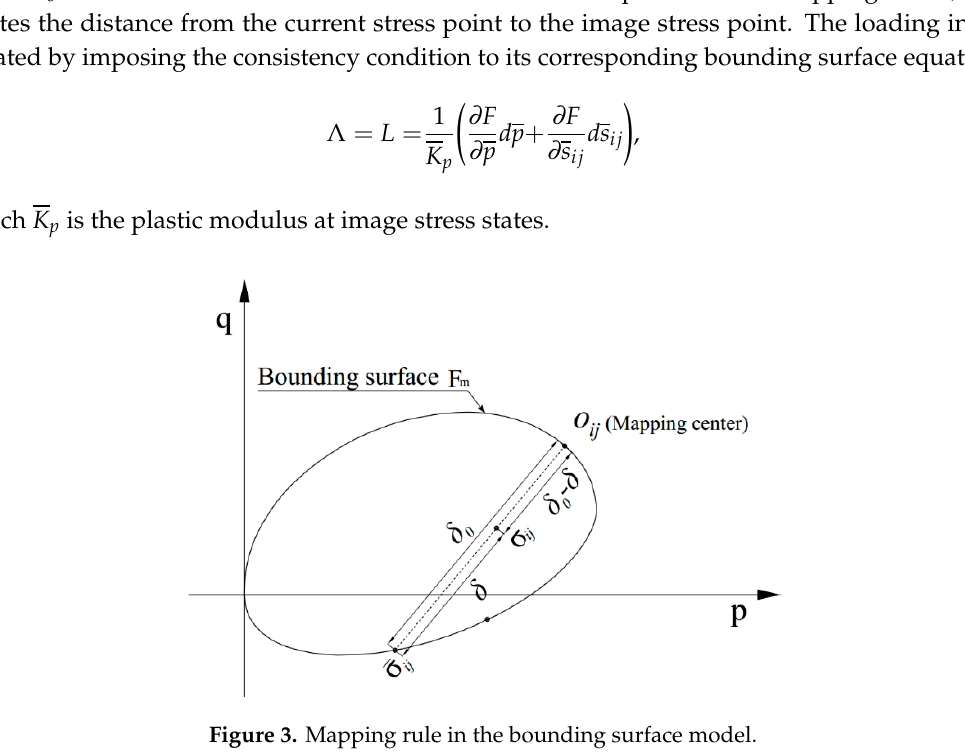
Figure 3. Mapping rule in the bounding surface model.